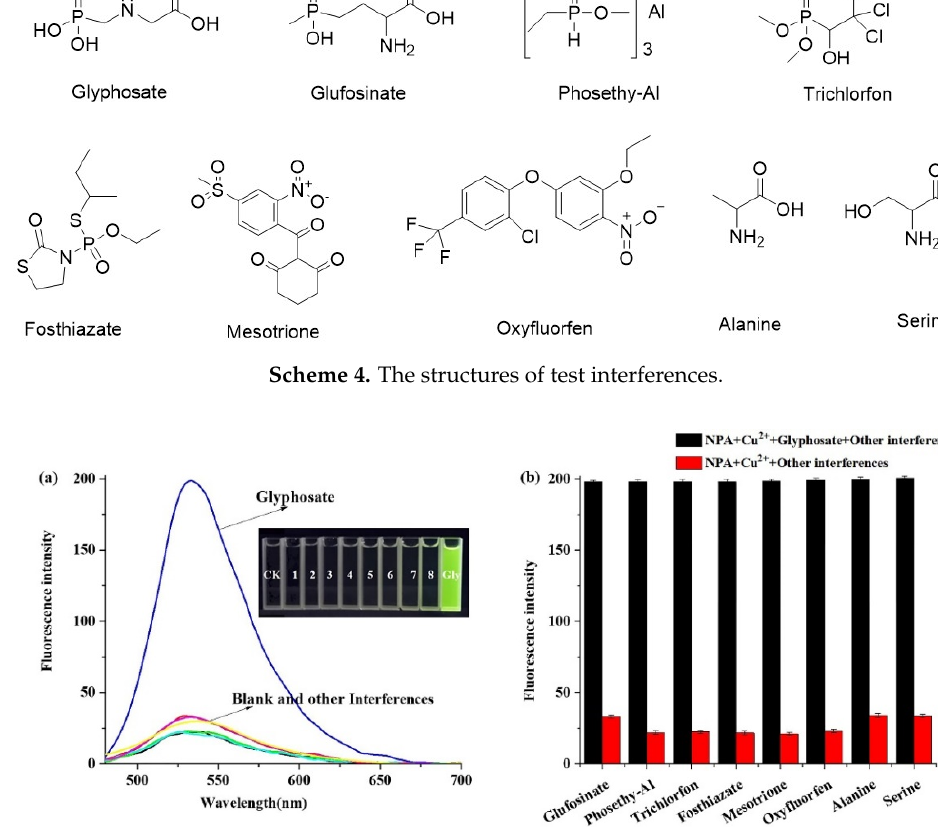
Table 1. Detection of glyphosate in water samples and soil samples using the proposed method. Samples